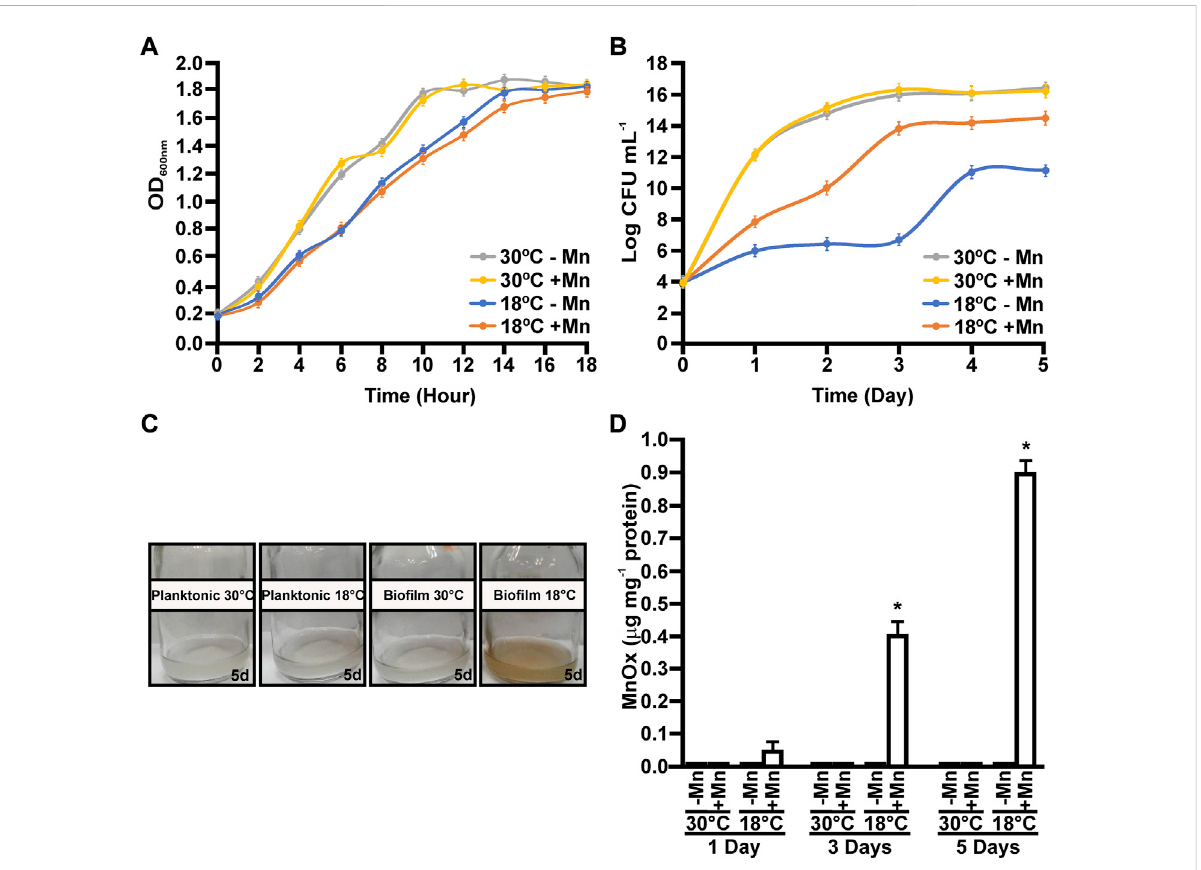
FIGURE 1 Growth and Mn(II)-oxidizing capacities of MOB-449 strain at different temperatures. MOB-449 was grown under planktonic measured as